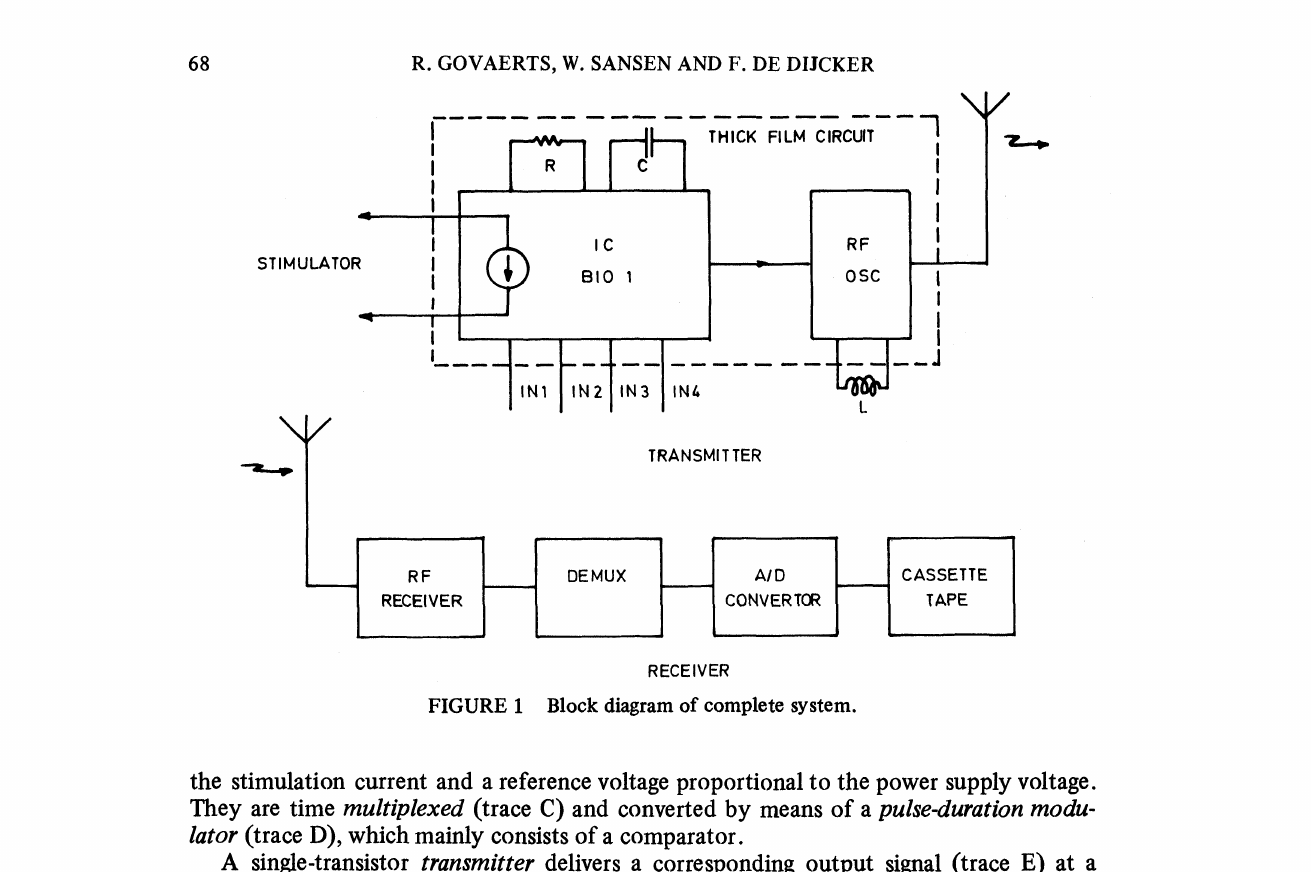
RECEIVER FIGURE 1 Block diagram of complete